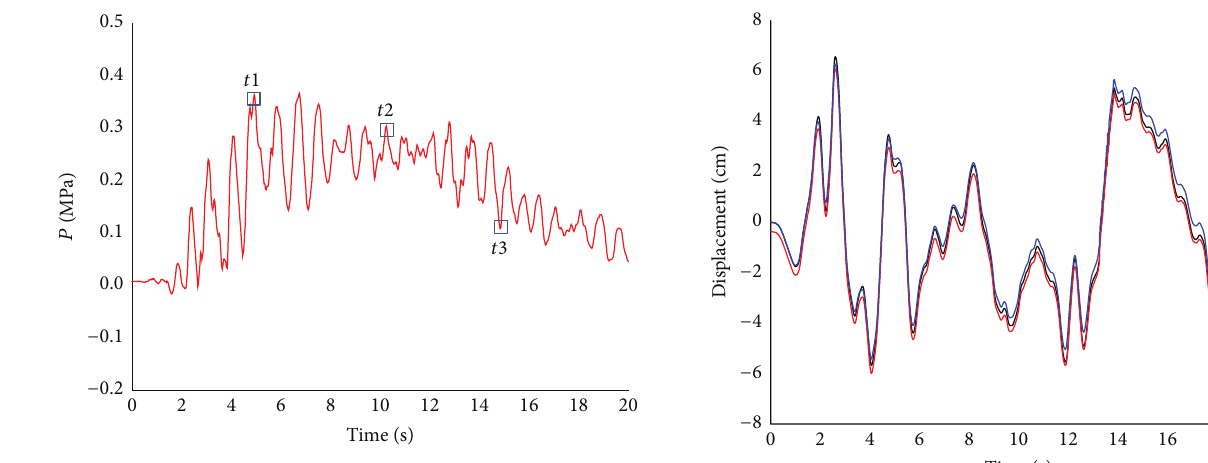
obtained from Figure 8: (1) the displacement time curve of the vault, haunch, and inverted arch almost coincides; (2) 𝑋 - displacement reaches the maximum 6.56 cm at 𝑡 = 2.60 s and reaches the minimum − 5.67 cm at 𝑡 = 4.07 s; (3) the displacement reaches the wave peak or trough at the same time, indicating that various locations are in a synchronous vibration